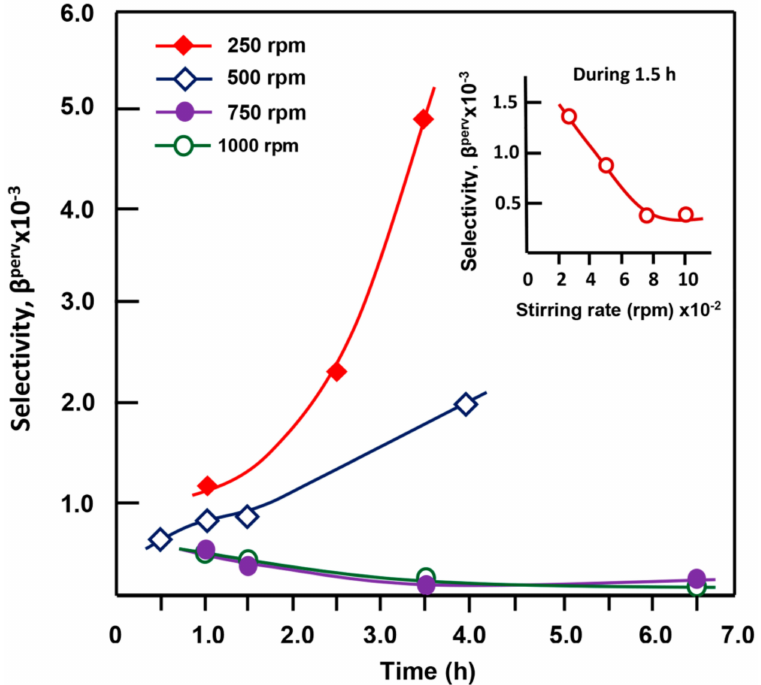
Figure 8. Variation of the selectivity of the SILICONE1200-480 µ m membrane with respect of the organic mixuture versus time at different stirring